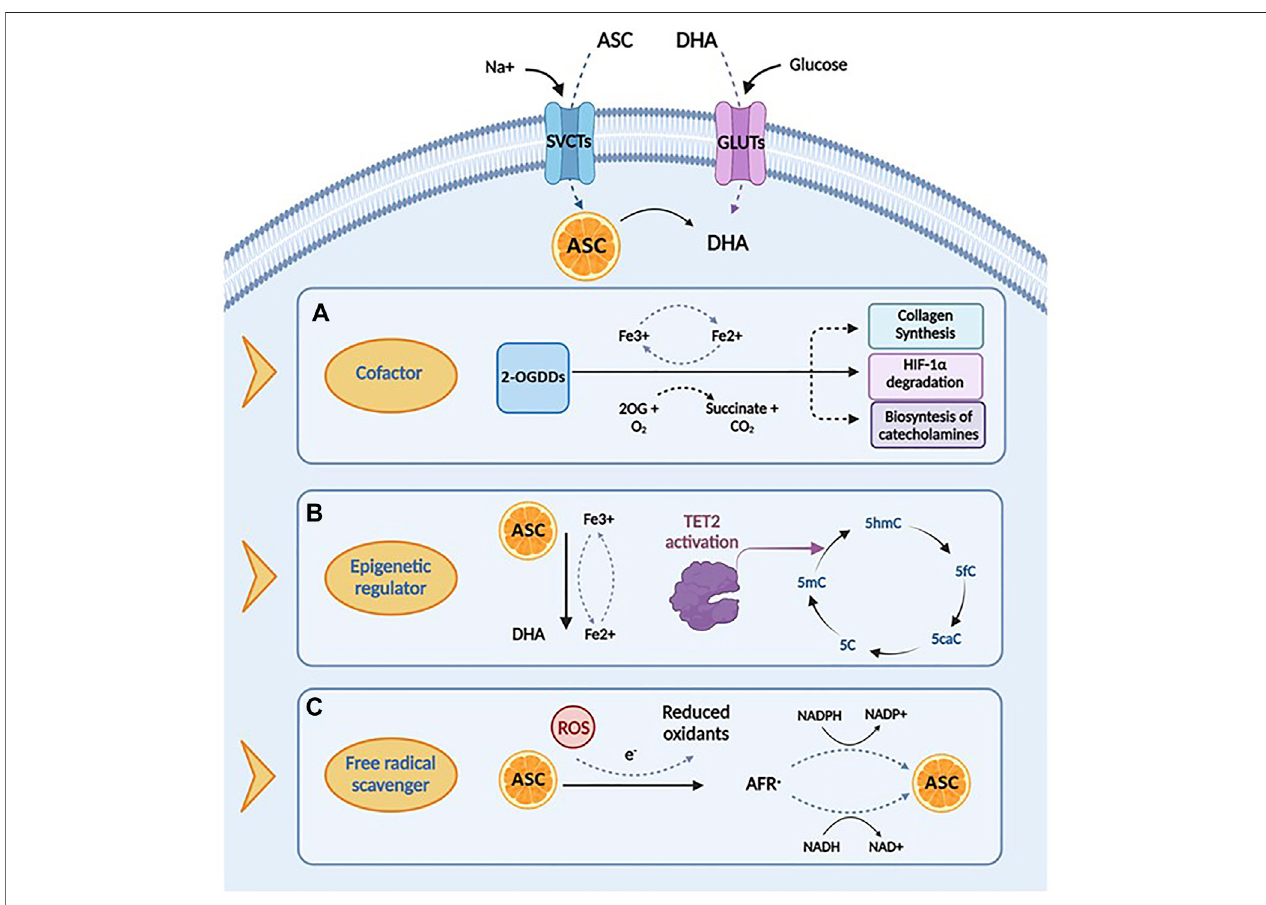
FIGURE2| Biologicalfunctionsandmechanismsofaction ofascorbicacid. (A) Ascorbicacidplaysanimportantroleinseveralbiologicalprocesses byacting asa cofactor for 2-oxoglutarate dependent dioxygenases (2-OGDDs) that have a wide range of biological functions, including collagen synthesis, HIF-1 α degradation and biosyntesis of catecholamines. (B) Ascorbic acid can act as an epigenetic regulator by enanching the activity of TET2 enzyme, that catalyzes the conversion of 5- methylcytosine (5-mC), into 5-hydroxymethylcytosine (5-hmC), inducing DNA demethylation. (C) Ascorbic acid has important roles in scavenging free radicals, having the ability to donate an electron to reactive oxygen species (ROS) to form a relatively stable ascorbyl-free radical (AFR). Created with Biorender.com.